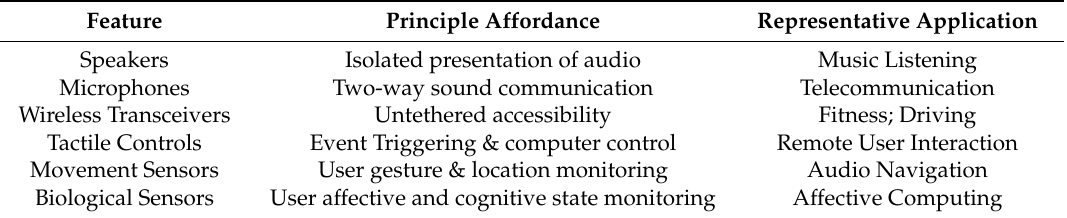
Table 1. Summary of ear-mounted affordances.